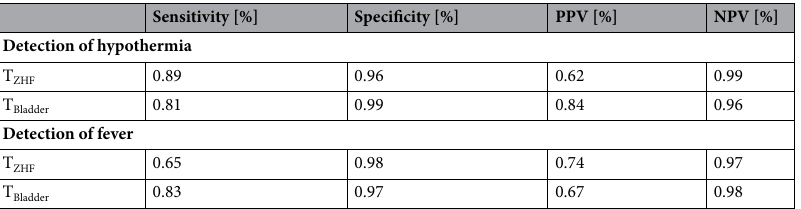
Table 1. Sensitivity, specificity, positive and negative predictive values for the detection of hypothermia and fever of both methods. T ZHF temperature measured with a zero-heat flux thermometer, T Bladder bladder temperature, PPV positive predictive value, NPV negative predictive value.